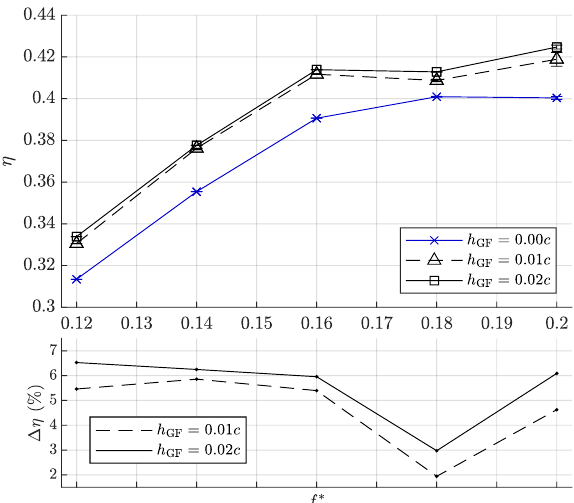
Figure 10. Effect on performance ( top ) and relative performance improvement ( bottom ) of OFTs operating at different reduced frequencies ( f ∗ ) with α 0 = 29 ◦ when fitted with double GFs of h GF = 0.01 c and 0.02 c